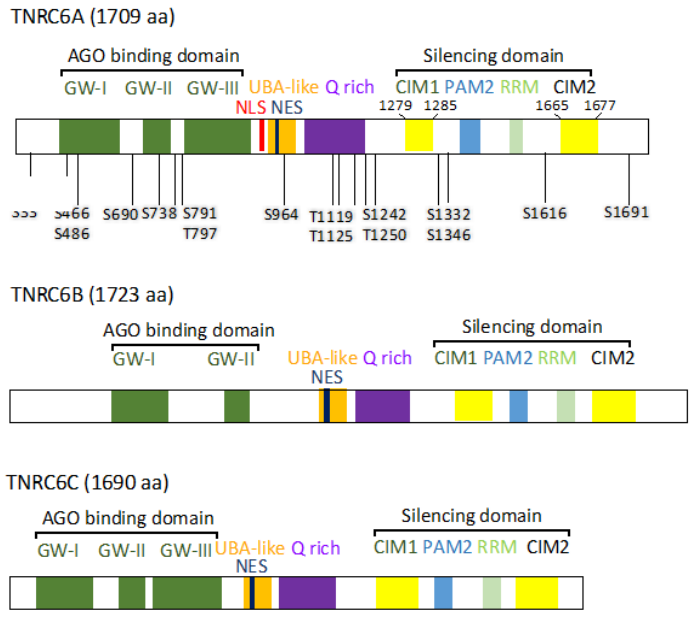
Figure 1. Domain structures of human TNRC6A, TNRC6B, and TNRC6C. N-terminal regions of TNRC6 family proteins are Argonaute (AGO)-binding domains, and C-terminal regions are silencing domains. QW indicates highly homologous GW/WG regions. NLS, nuclear localization signal; NES, nuclear export signal; UBA-like, ubiquitin-associated like domain; Q rich, glutamine-rich region; PAM2, poly A binding protein binding motif 2; RRM, RNA recognition motif; CIM1, carbon catabolite repressor4-negative on TATA (CCR4-NOT) interaction motif 1; CIM2, CCR4-not interaction motif 2.